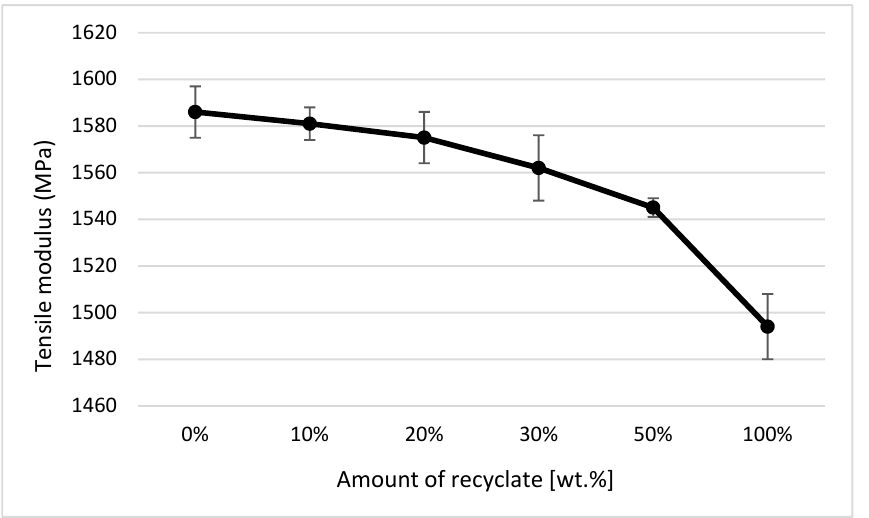
Figure 11. Dependence of the modulus of elasticity on the proportion of weight of the recycled material before exposure of samples to elevated temperature.